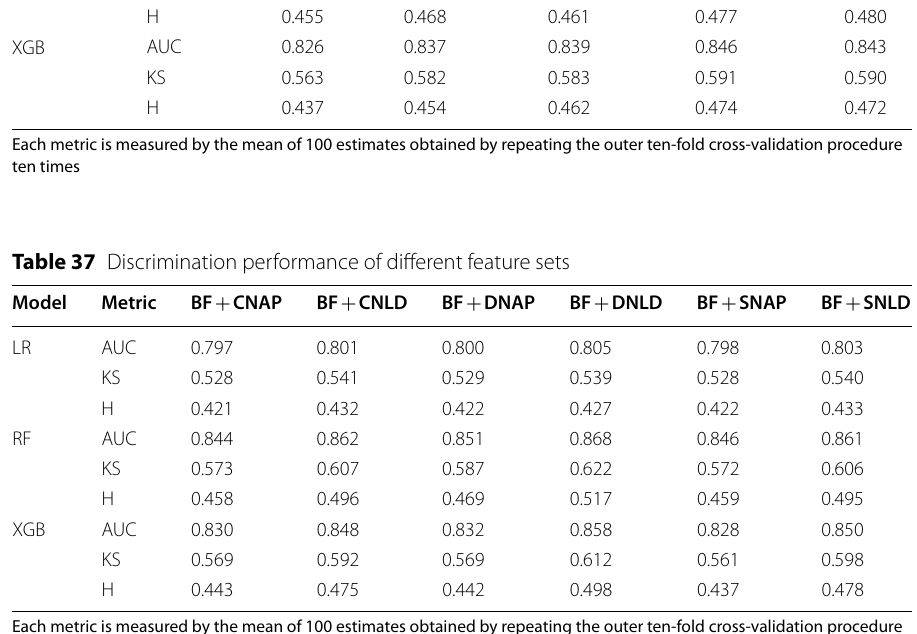
Each metric is measured by the mean of 100 estimates obtained by repeating the outer ten-fold cross-validation procedure ten times